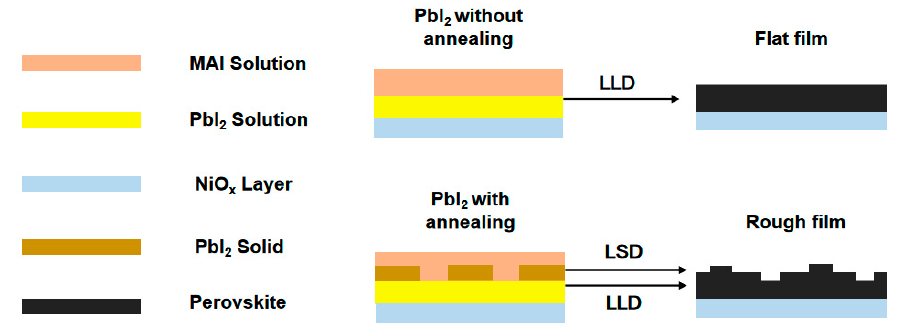
di ff erent annealing